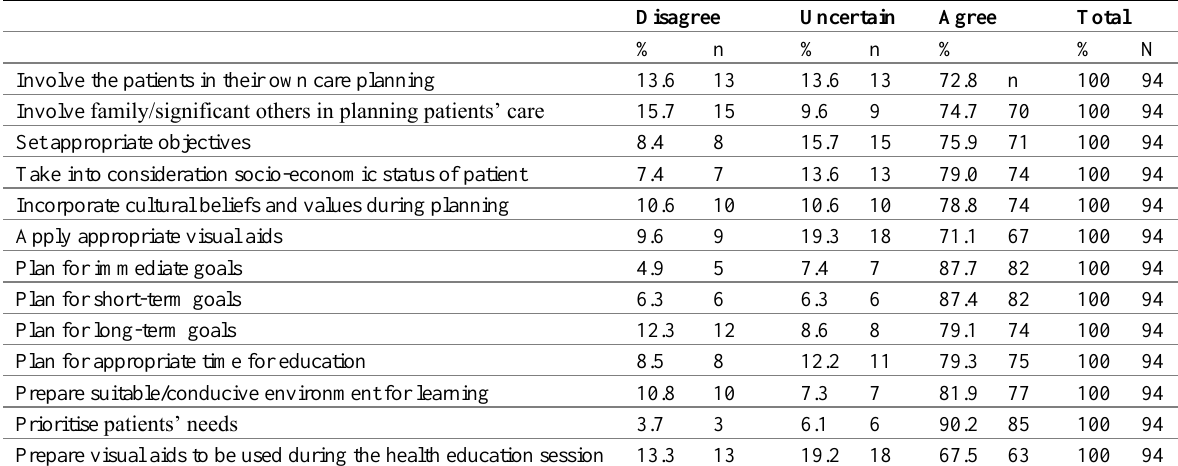
Table 2: Planning for health education